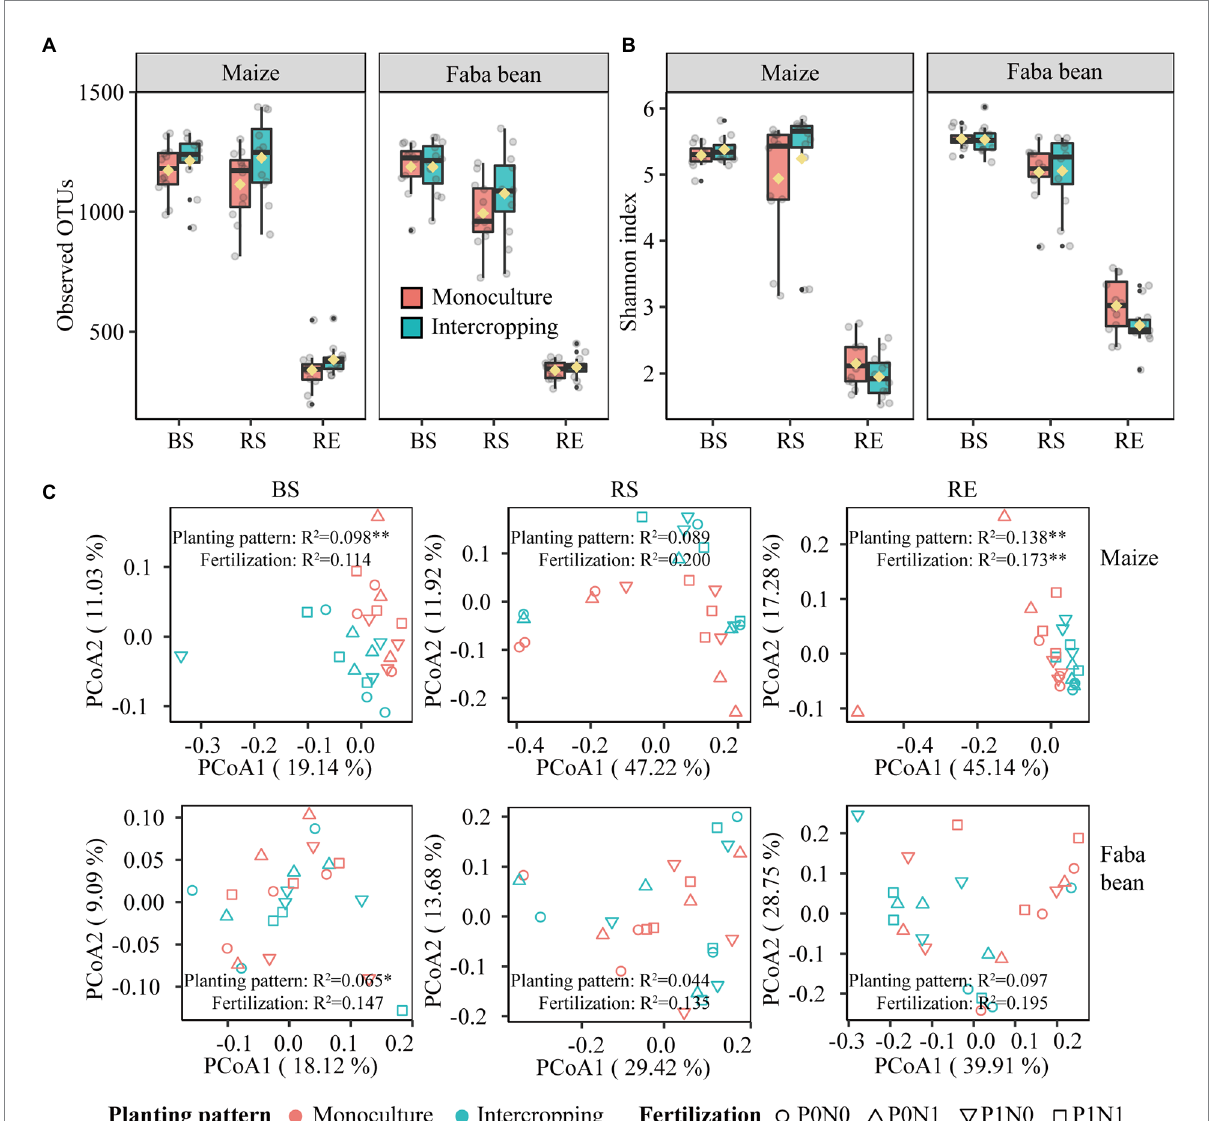
FIGURE 3 Bacterial alpha diversity of observed OTUs (A) and Shannon index (B) in bulk soil (BS), rhizosphere soil (RS) and root endosphere (RE) of maize and faba bean as affected by planting pattern. Bacterial community composition in bulk soil, rhizosphere and root endosphere as affected by planting pattern and fertilization (C) . P0N0, no fertilization; P0N1, sole N fertilization at 180 kg N ha − 1 yr. − 1 as urea; P1N0, sole P fertilization at 40 kg P ha − 1 yr. − 1 as superphosphate; P1N1, N and P fertilization at 180 kg N ha − 1 yr. − 1 and 40 kg P ha − 1 yr. − 1 respectively; * p < 0.05; ** p <